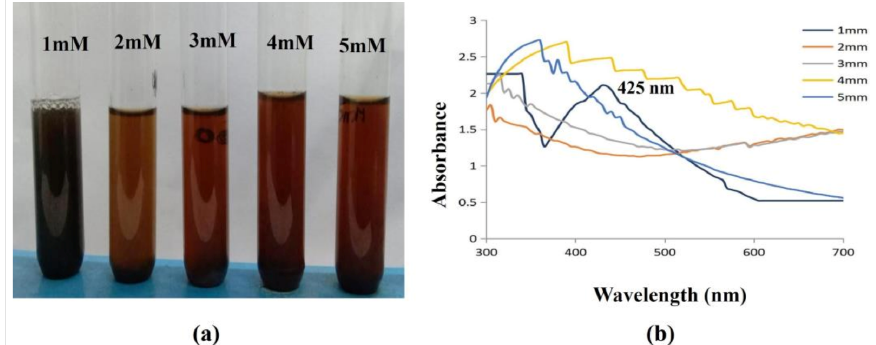
Figure 9. Effect of Concentration on synthesised AgNPs. ( a ) The synthesis of AgNPs was observed as a color shift towards red, indicating that the particle size gradually increases with concentration; ( b ) 1 mM concentration of AgNO 3- synthesized AgNPs, which was confirmed with a spectral peak at 425